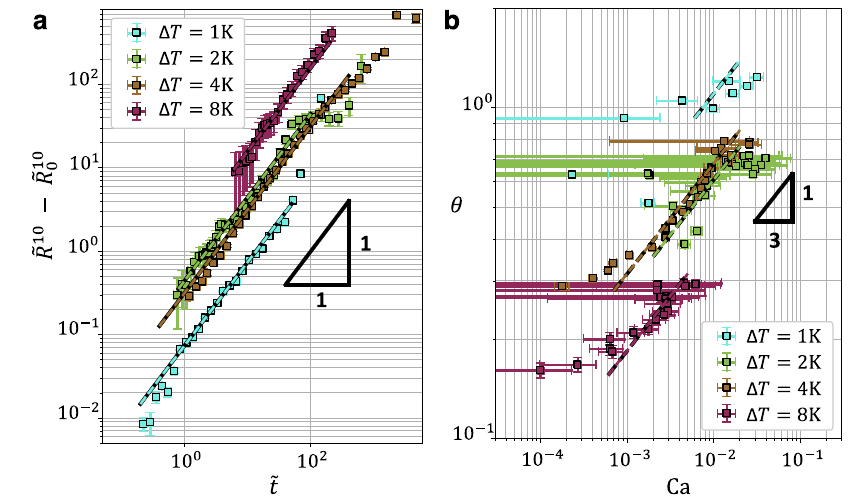
Fig. 3 | Rescaled data: Tanner and Cox – Voinov laws. a Rescaled contact radius ~ R 10 (cid:2) ~ R 010 as a function of rescaled time ~ t , for various temperatures Δ T as indicated. Thedashedlinesindicate fi tsEq.(4),with ℓ asafreeparameterforeachtemperature. b Contact angle θ as a function of capillary number Ca, for various temperatures Δ T